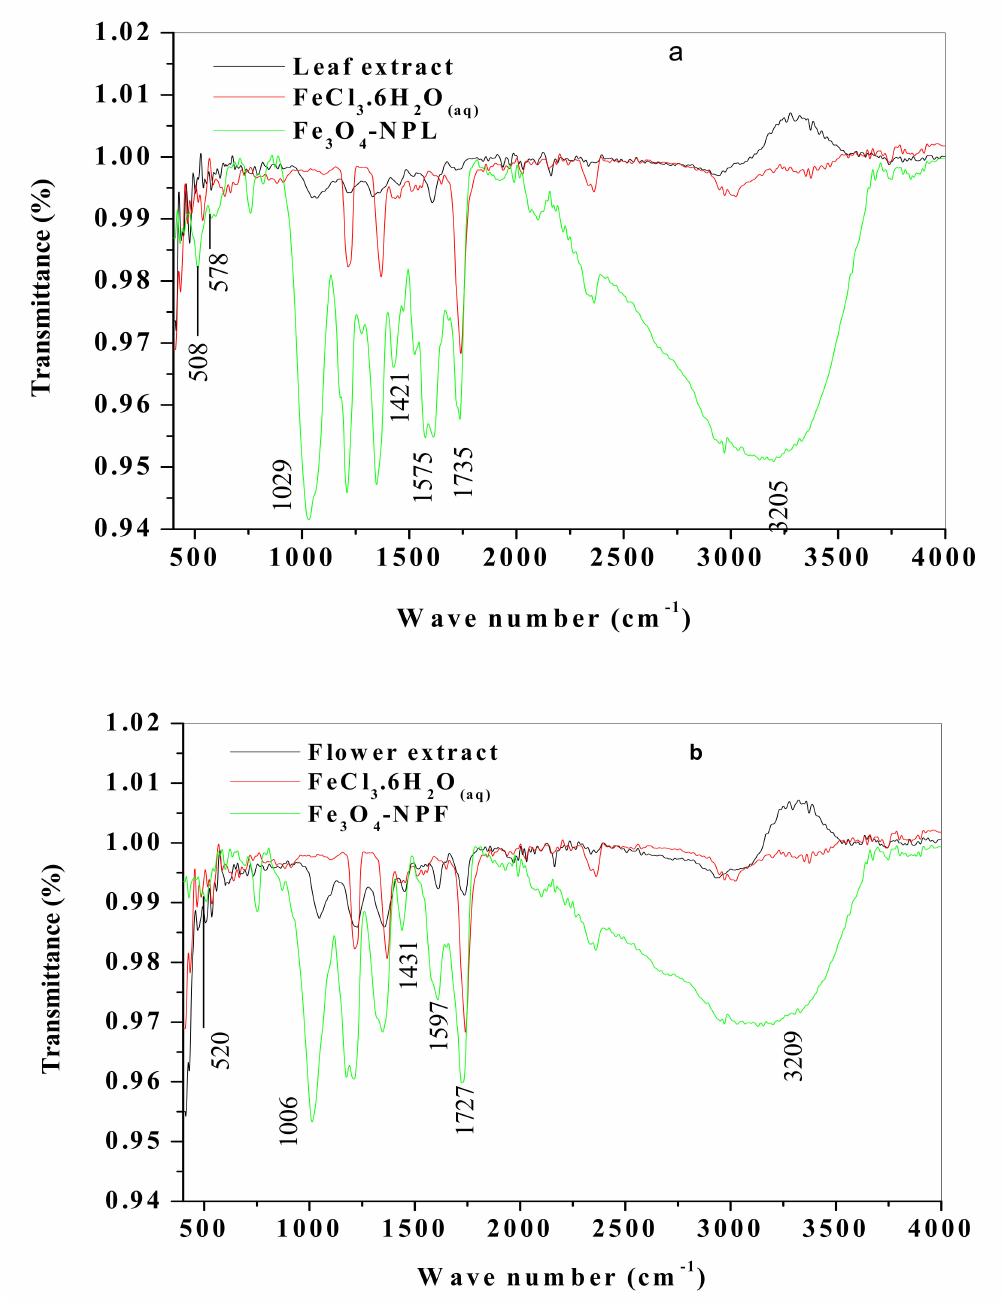
Figure 3. FTIR spectra of Fe 3 O 4 -NP synthesized by C. viminalis ( a ) leaf and ( b ) flower extracts,